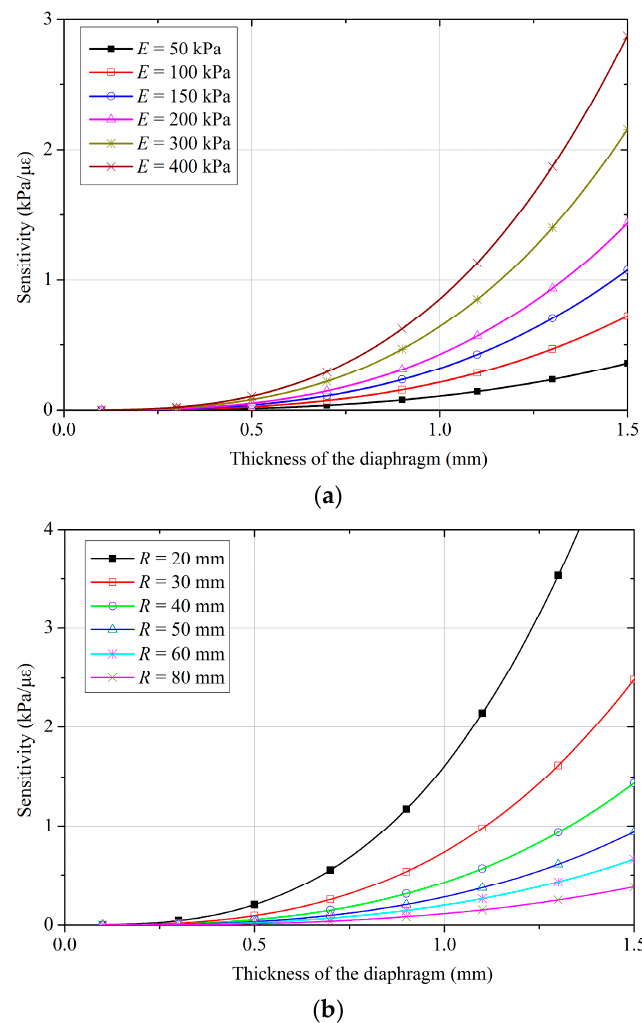
Figure 7. Sensitivity of the designed FPS with various thicknesses and ( a ) Young’s moduli, and ( b ) radii of the diaphragm. Sensors 2018 , 18 , x FOR PEER REVIEW